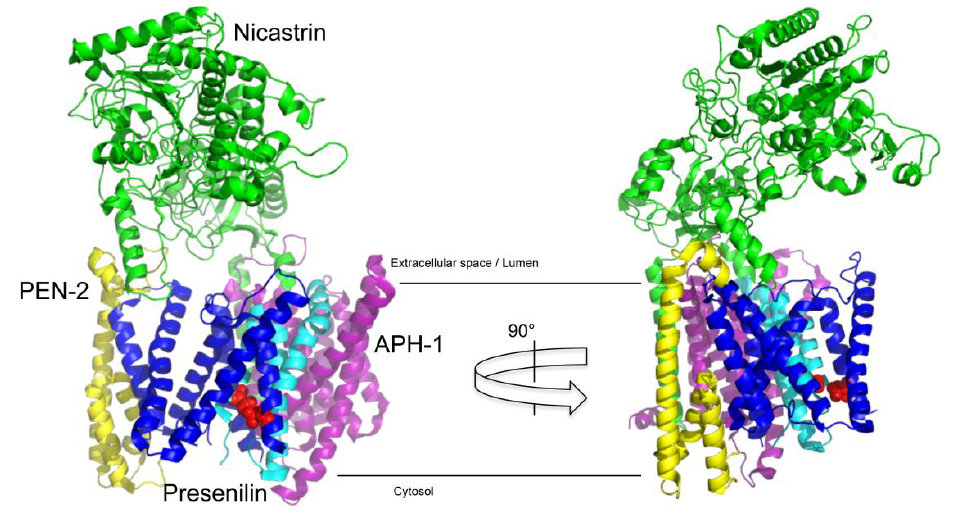
FIGURE 2: Structure of γ - secretase. The atomic resolu- tion structure of γ -secretase (PDB: 5FN3) shows a mem- brane embedded core con- taining the catalytic subunit presenilin-1 cleaved into NTF (blue) and CTF (cyan) flanked by the subunits PEN-2 (yellow) and APH-1a (purple), which is covered by the large bilobar extracellular domain of the nicastrin subunit (green). This domain allows nicastrin to serve as gatekeeper control- ling substrate access to the active site by excluding pro- teins with too large (or steri- cally incompatible) ectodo- mains. Red spheres depict the active sites aspartate resi-